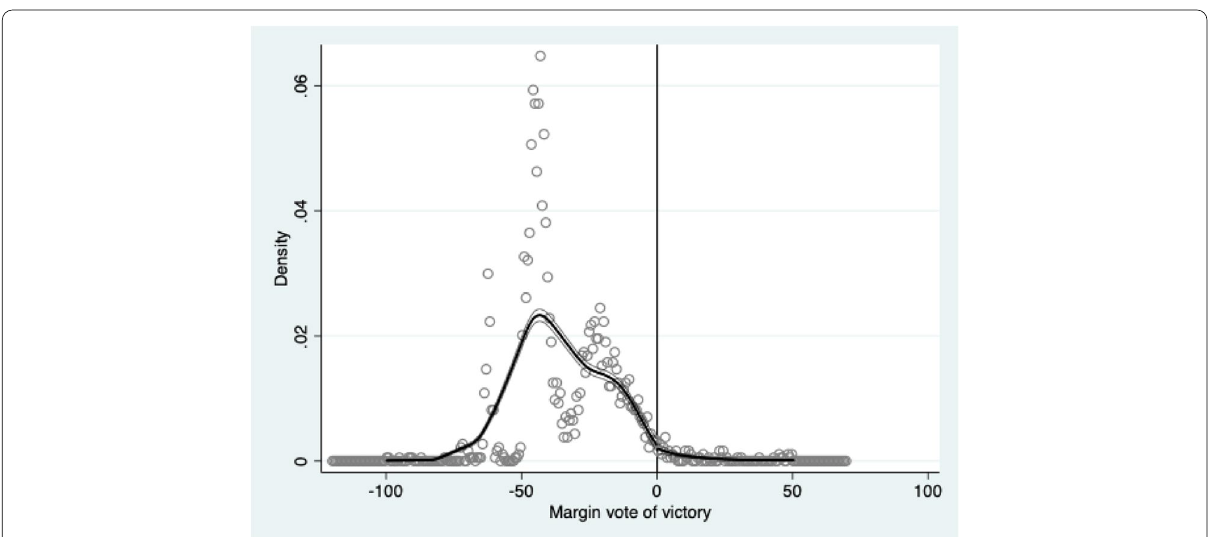
Fig. 3 McCrary [118] test for continuity. This figure presents a graphic outlook of McCrary’s [118] test for the continuity of vote share distribution around the cut-off. The null hypothesis is continuous distribution around the cut-off. With a p -value of 0. 29), the null fails to be